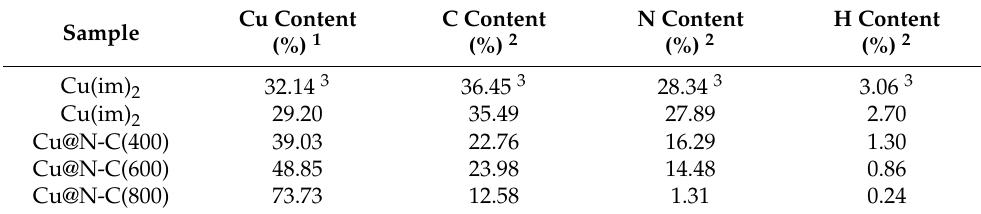
Table 1. The contents of Cu, C, N, and H of